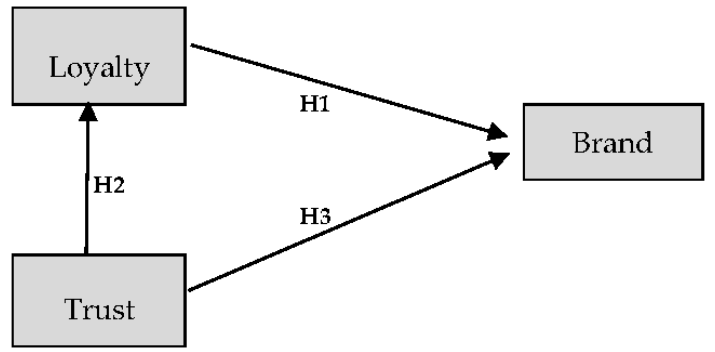
Figure 1. Conceptual model.